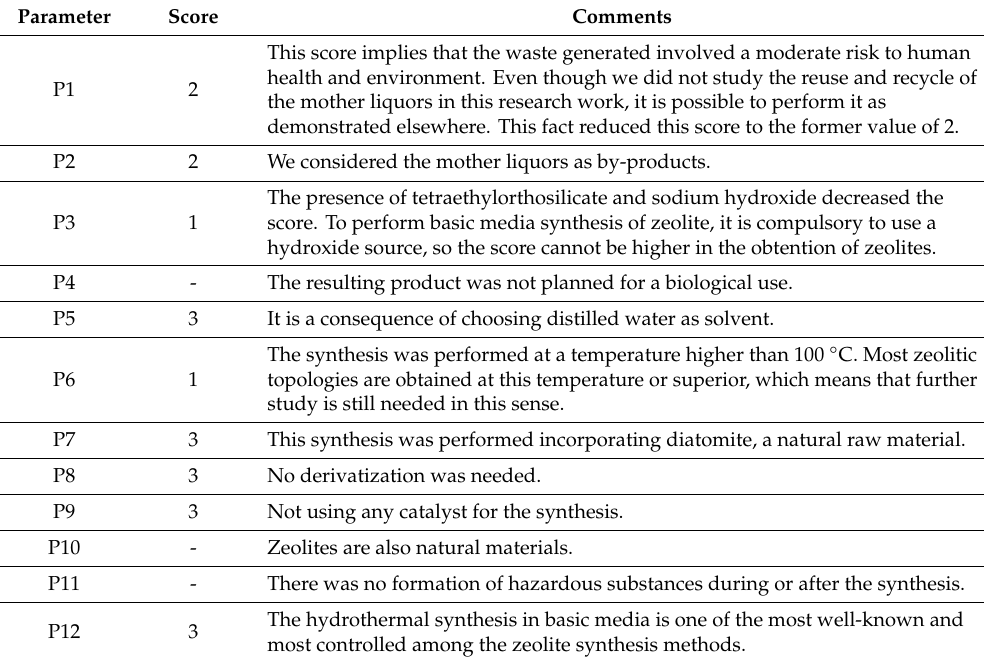
Table 1. Green Star